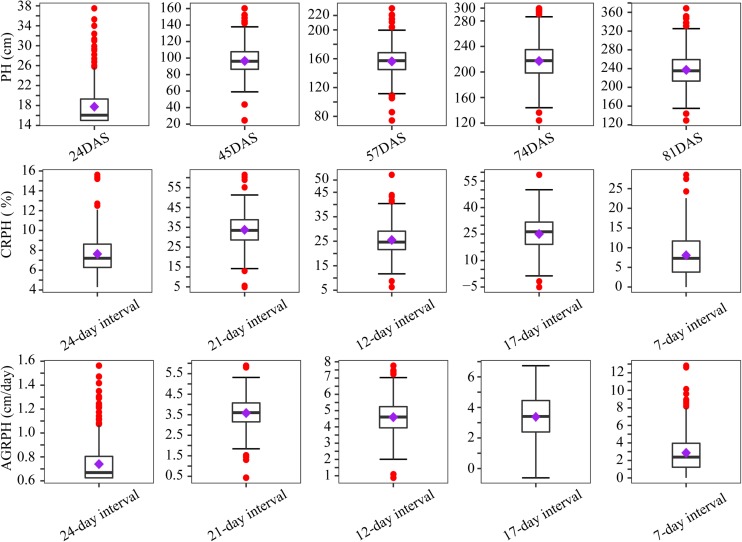
Boxplots showing distribution of phenotypic traits before treating outliers. Boxplots are based on three traits from 400 plots. The solid line in the box indicates the median and the purple square is the mean. The red points are outliers. PH, plant height; PH, plant height; AGRPH, average growth rate of plant height; CRPH, contribution rate of plant height; DAS, days after sowing.